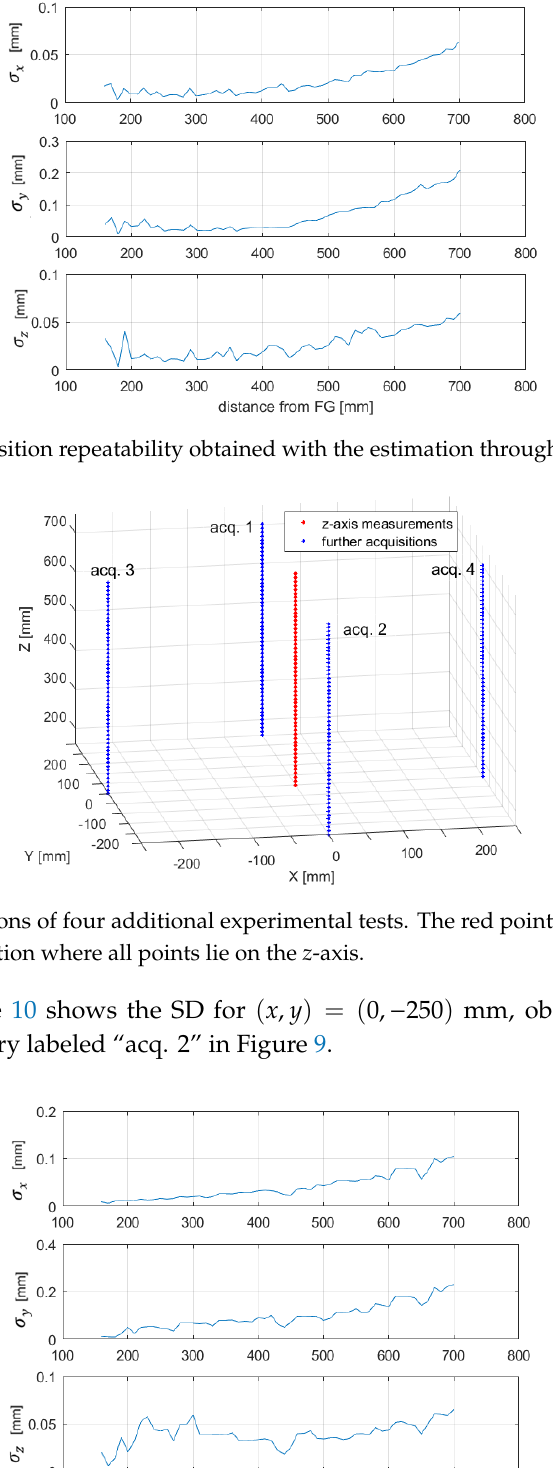
Figure 10. Position repeatability obtained with the estimation through gradients for the trajectory labeled “acq.